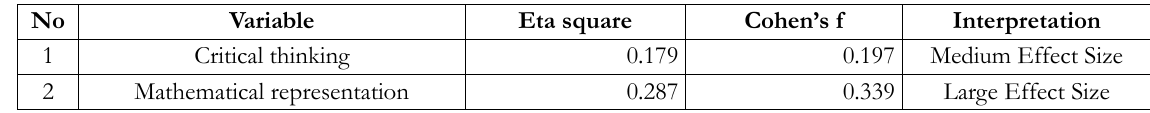
Table 13. Result of analysis of effect